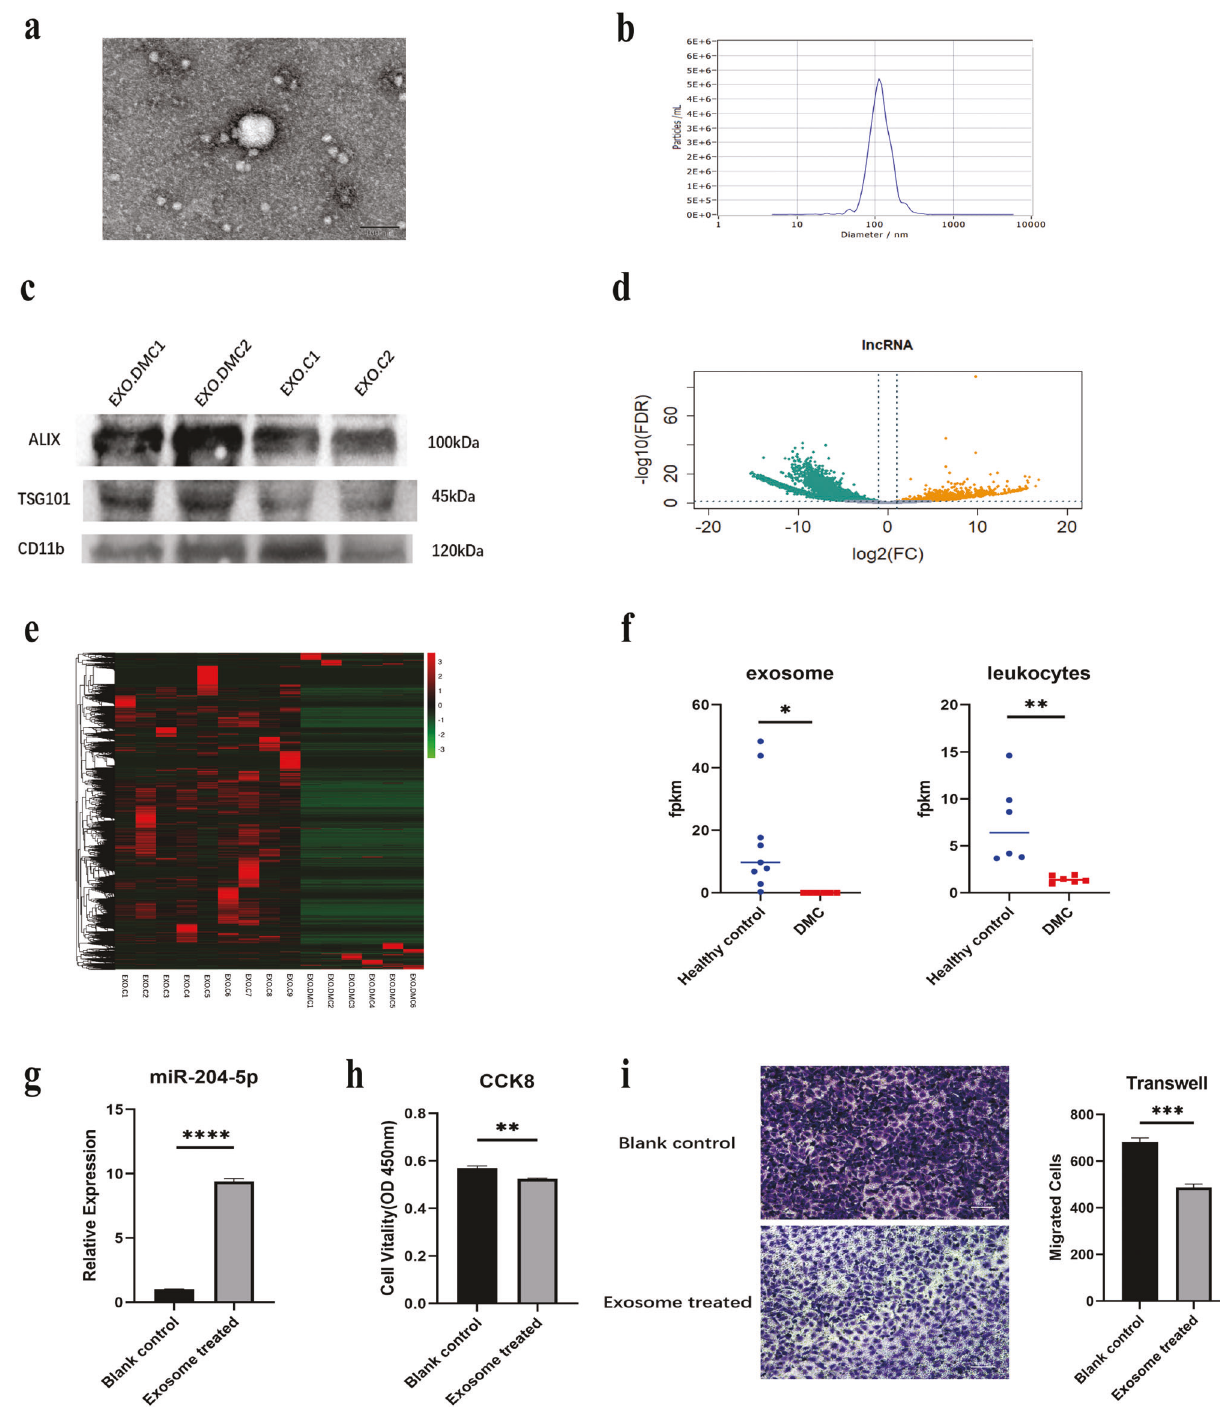
Fig. 6 LYPLAL1-DT were transferred from leukocytes to HUVEC via exosomes in DMC patients. a Morphology of leukocytes-derived exosomes were shown by TEM. b Leukocyte-derived exosomes were observed to be between 30 and 120 nm in size analyzed by NTA. c Western Blot was used to examine exosome biomarker ALIX and TSG101, and the leukocyte surface marker CD11b. d , e Differentially expressed lncRNAs were identi fi ed from a Volcano plot and hierarchical cluster analysis, shown as a heatmap (DMC n = 6, healthy control n = 9). f RNA-sequencing of DMC patients-derived exosomes and DMC patients ’ leukocytes shows a similar trend of LYPLAL1-DT expression level. g The expression of miR-204-5p in HUVECs increased when treated with exosomes derived from DMC patients ’ serum compared with control. Exosomes derived from DMC patients ’ serum signi fi cantly decreased cell viability and migration of HUVEC compared with controls detected by ( h ) CCK8 and ( i ) Transwell